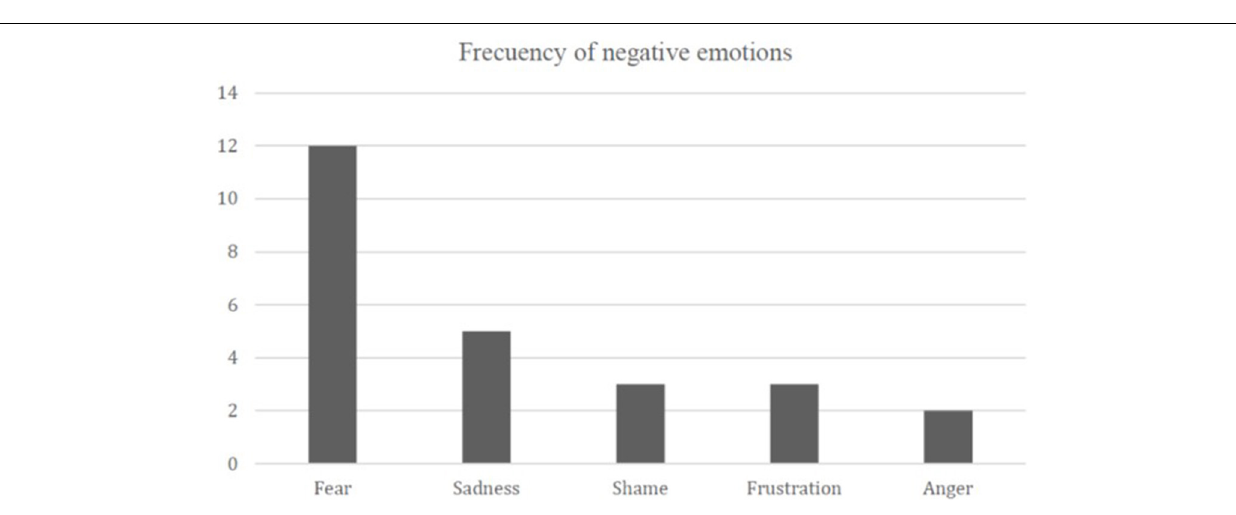
FIGURE 6 | Frequency of different dimensions of the teacher as a facilitator of positive valence emotions, according to the memories of the future teachers analyzed.